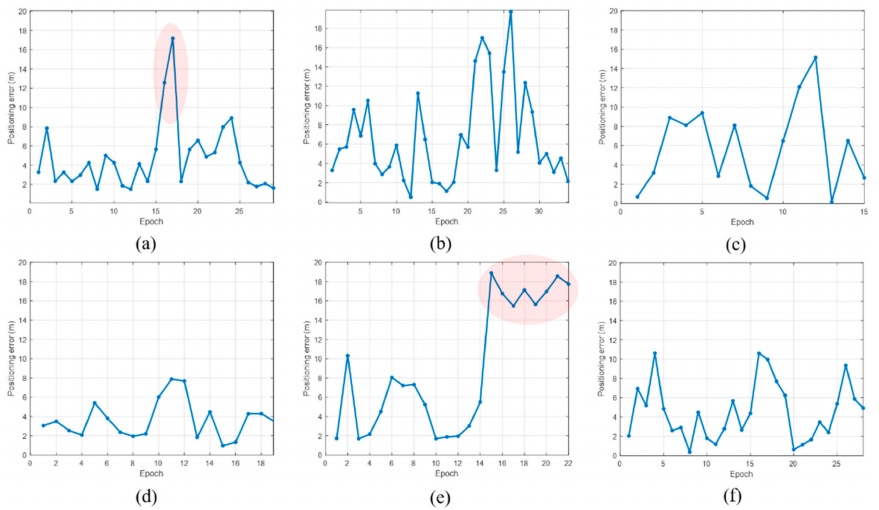
Figure 15. Positioning error by epoch for each scenario. ( a ) position error of scenario 1; ( b ) position error of scenario 2; ( c ) position error of scenario 3; ( d ) position error of scenario 4; ( e ) position error of scenario 5; ( f ) position error of scenario